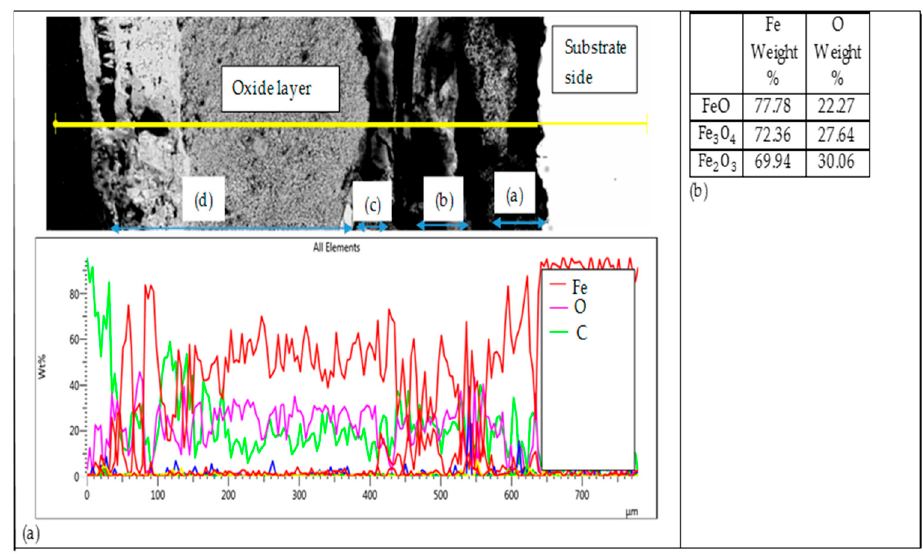
Figure 7. ( a ) Cross-sectional view EN8 oxide thickness and ( b ) wt.% constituents of the major composition of the oxides.